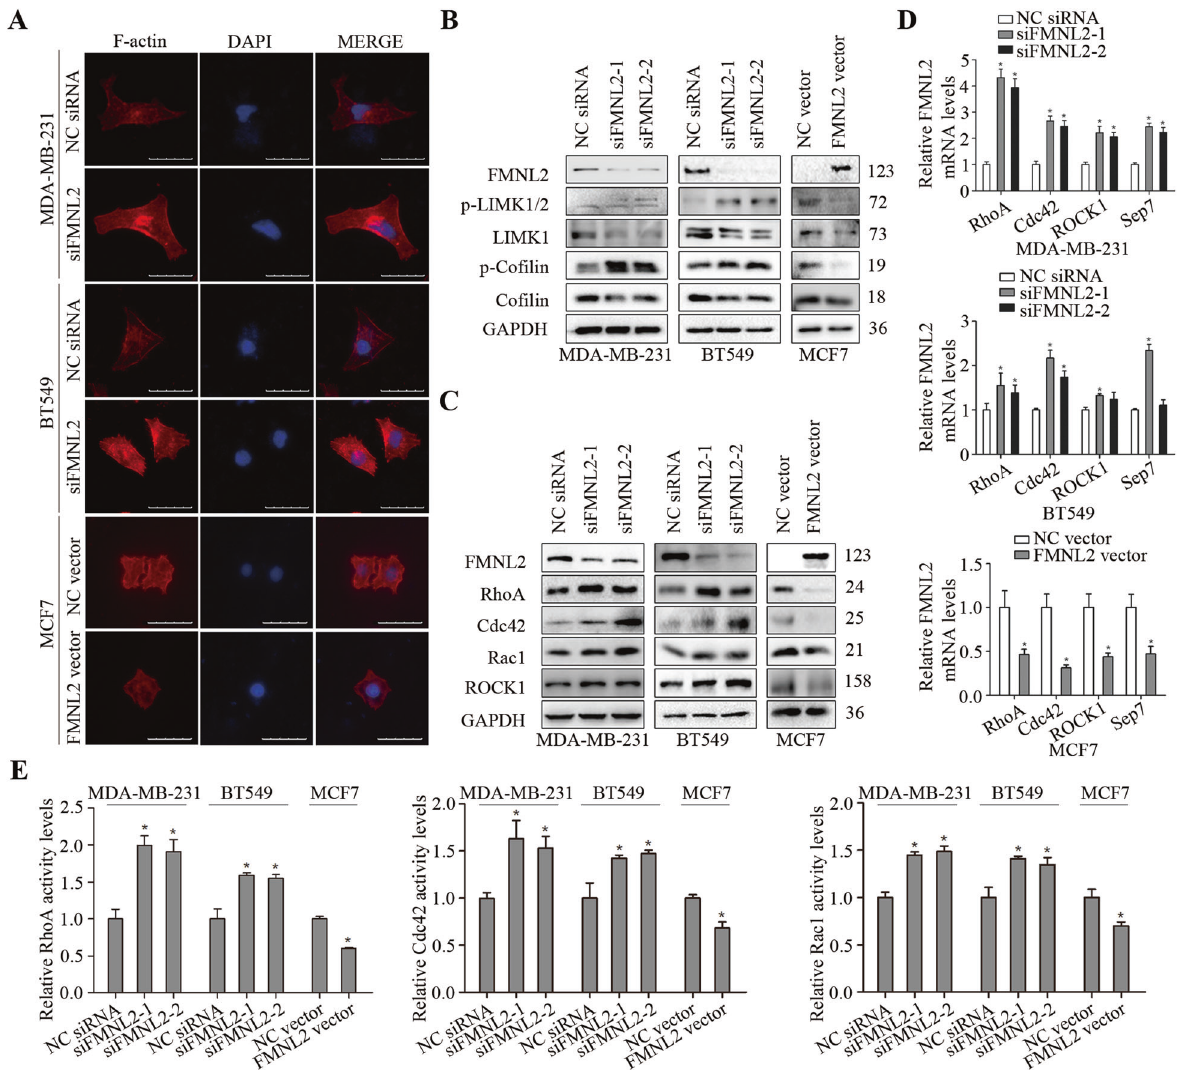
Fig. 2 Effects of FMNL2 on cytoskeleton architecture and RhoA/LIMK/Co fi lin pathway in breast cancer cells. After transfection for 48 h, cultured cells were processed for indicated assays. A Representative fl uorescent images of F-actin cytoskeleton were displayed. Scale bar, 50 μ m. B The levels of LIMK/Co fi lin-related molecules were determined by western blotting. C The levels of RhoA/ROCK1-related molecules were determined by western blotting. D The levels of RhoA, Cdc42, ROCK1 and Sep7 mRNA were measured by qRT-PCR. E The activity levels of RhoA, Cdc42 and Rac1 were measured. * P < 0.05 versus corresponding control